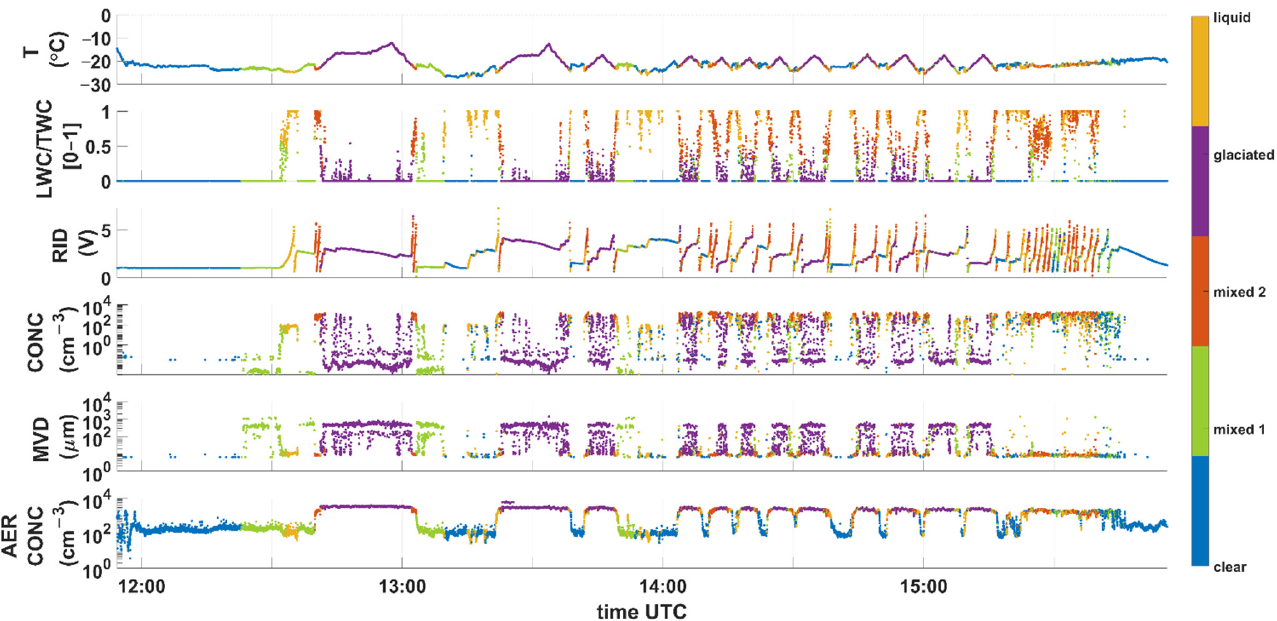
Figure 10. Probability distribution functions of 11 input variables in flight F28 (5 March 2019), color coded by the k-means algorithm identified clusters.